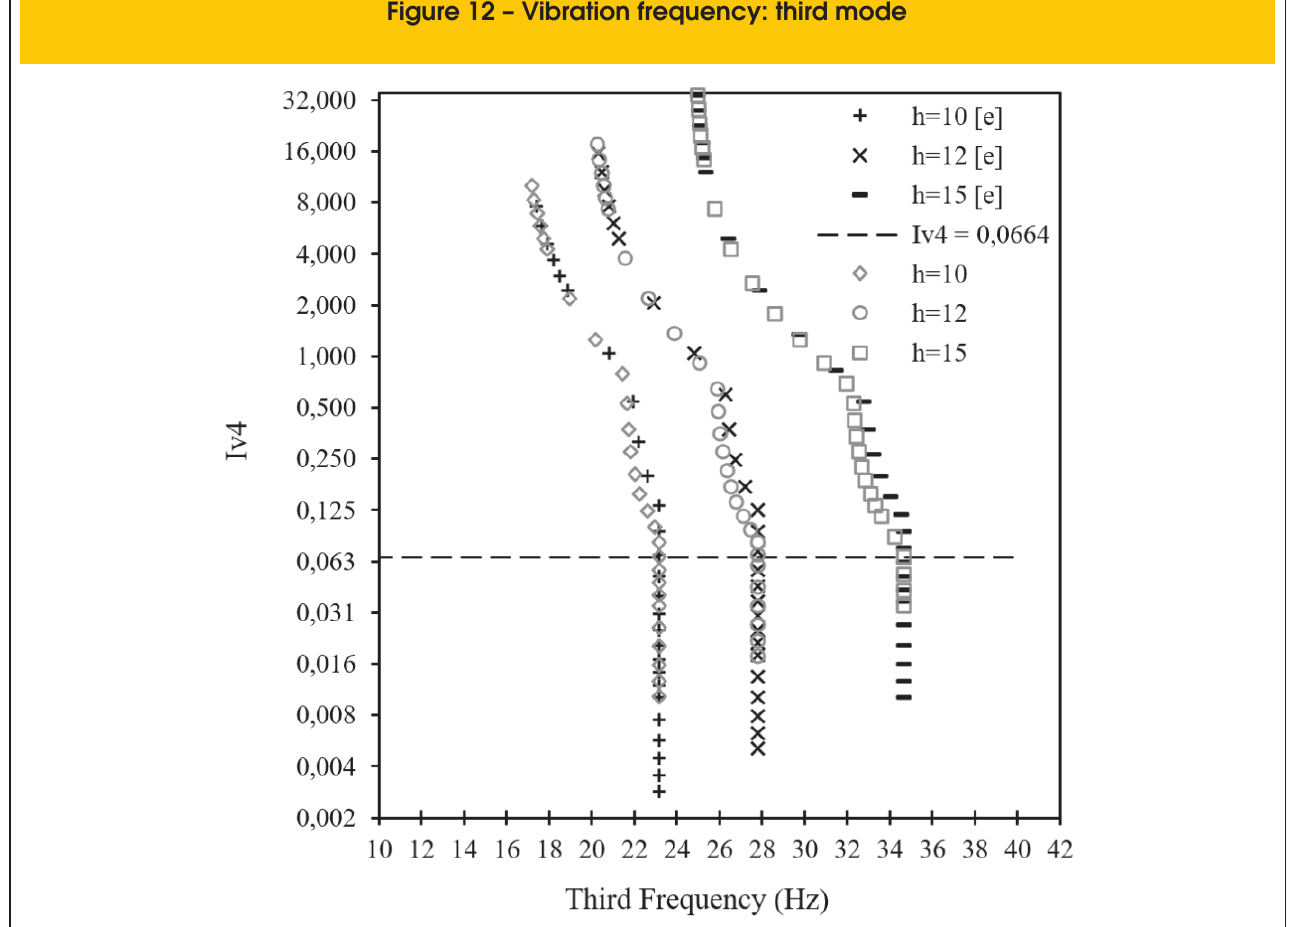
Figure 12 – Vibration frequency: third